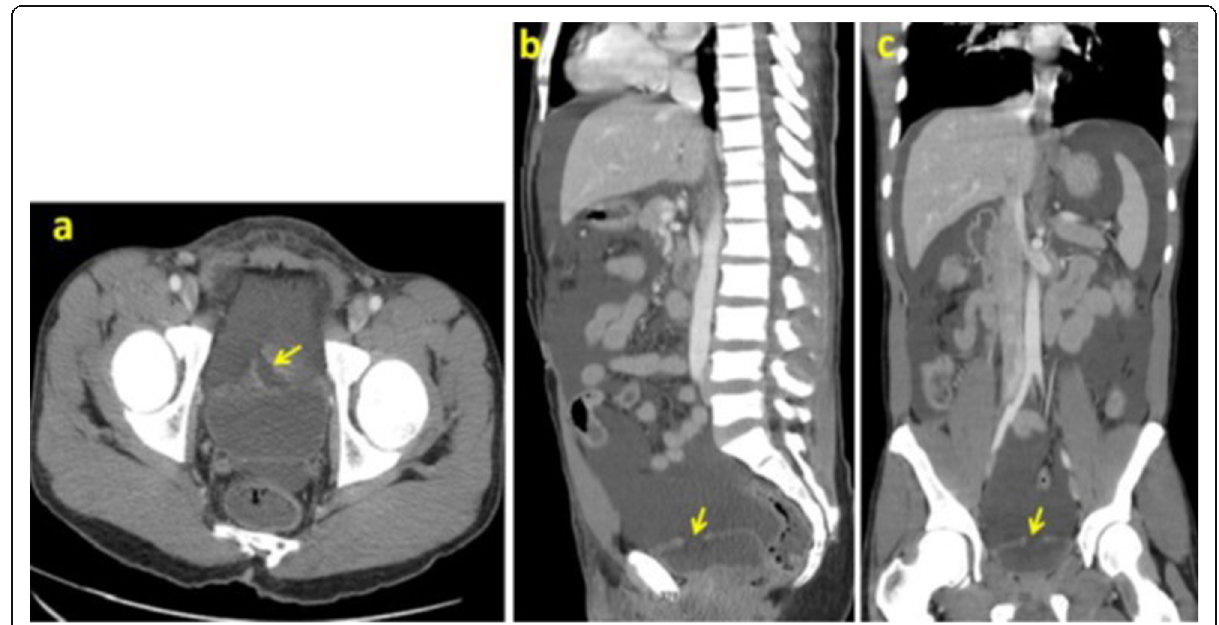
Fig. 2 CT scan images of a rupture of the urinary bladder dome (yellow arrow)